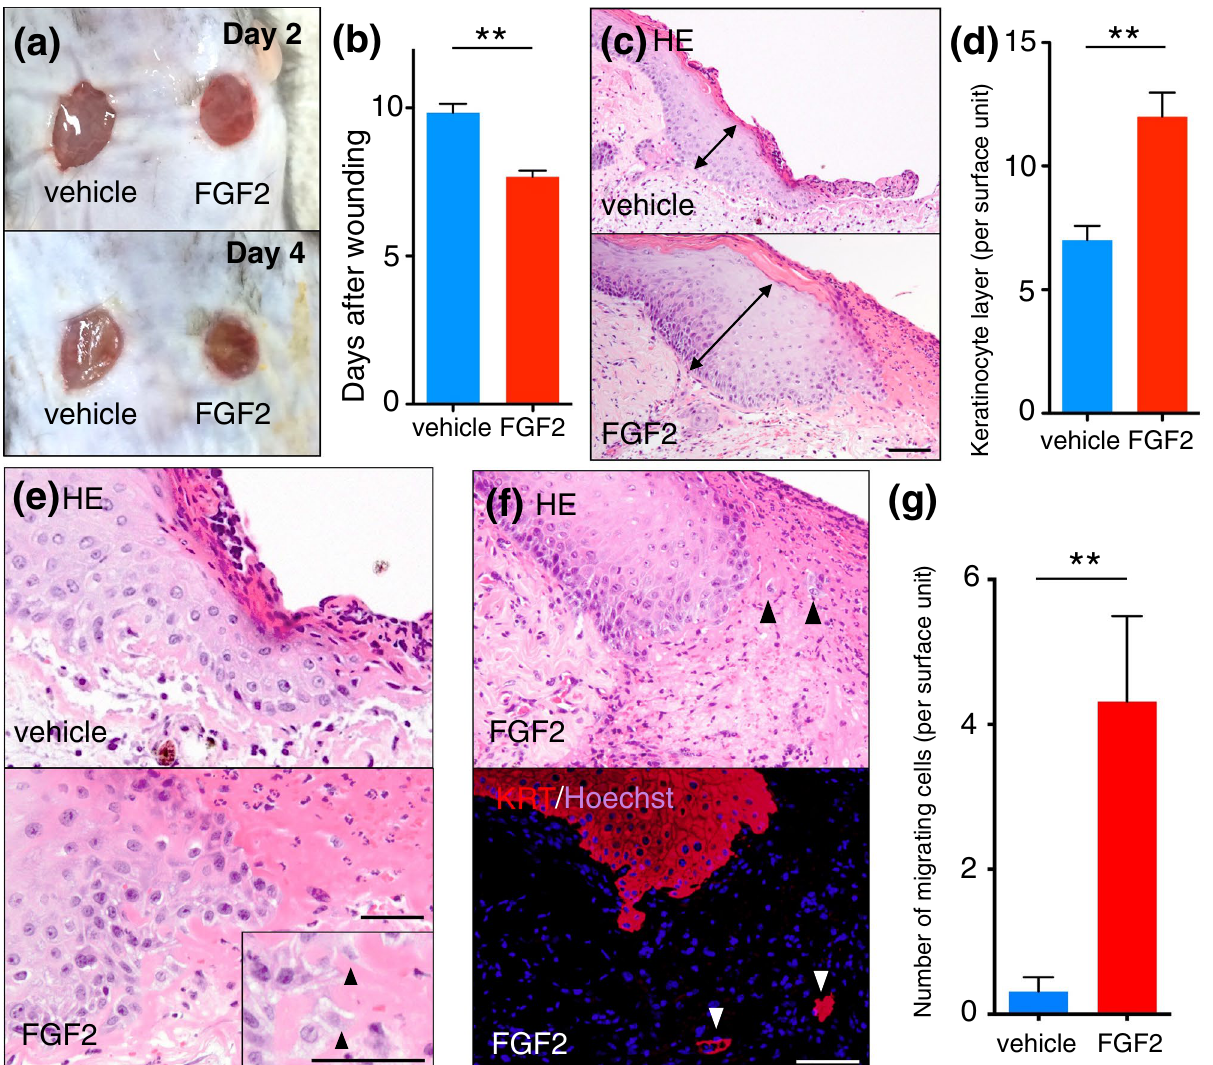
Figure 1. FGF2 accelerated wound healing, epidermal hypertrophy and keratinocytes migration at wound edge. ( a ) Murine wounds were created on the dorsal skin using 6 mm punch, and FGF2-treated wounds were significantly smaller on day 4. (b) Days required for wound closure were significantly decreased by FGF2 treatment. ( c , d ) FGF2-treated wounds demonstrated a more thickened epidermis (double arrow) than vehicle- treated wounds. Scale bar: 40 μm. ( e ) At the wound edge, spindle-shaped keratinocytes (arrow heads) were observed in FGF2-treated wounds (higher magnification images at the corner). Scale bar: 20 μm. ( f )